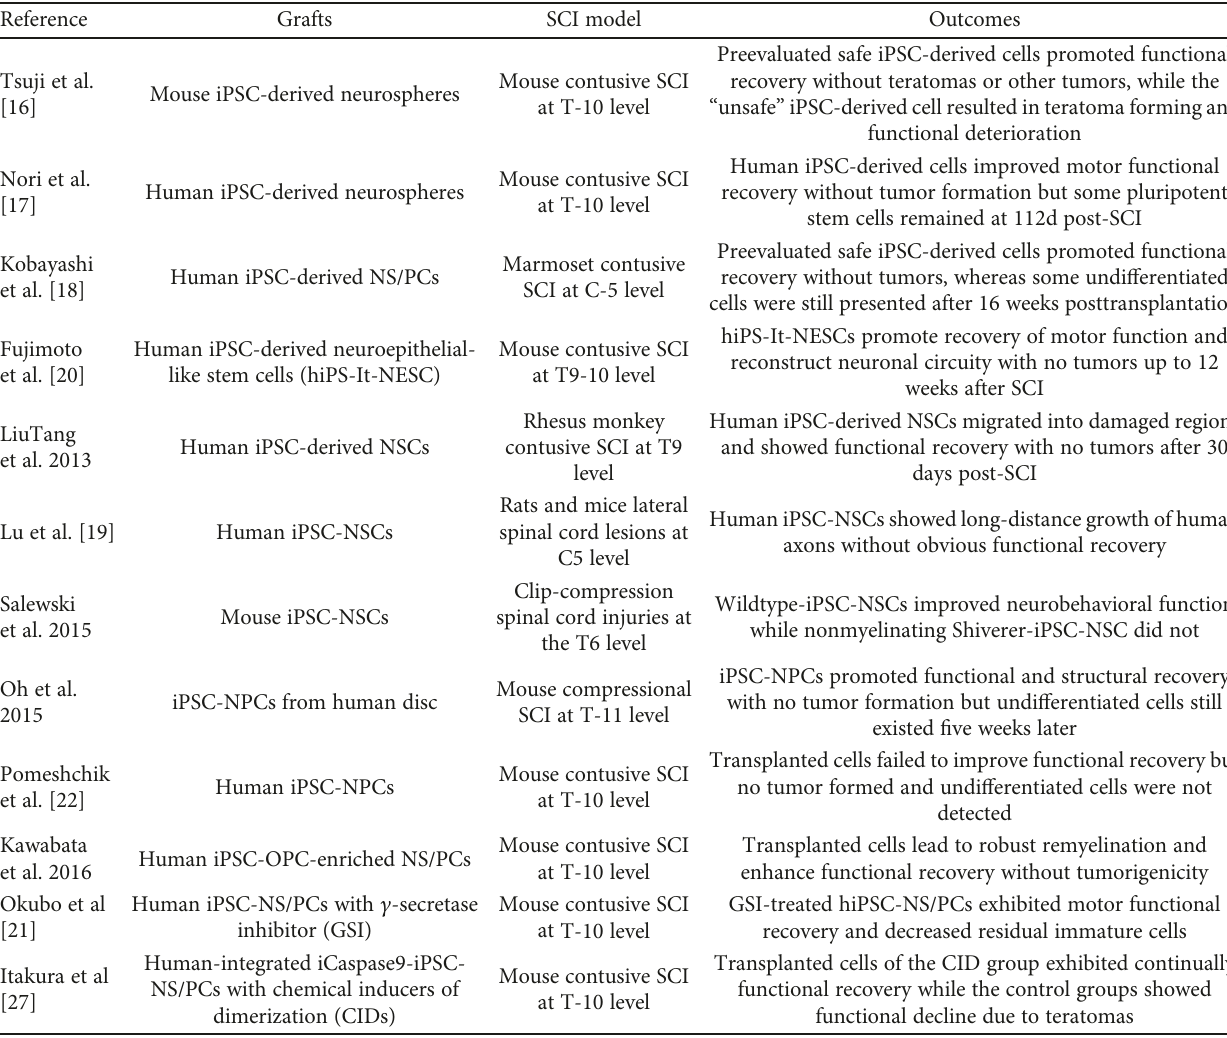
Table 1: Some current studies of iPS cell transplantation in the SCI model. This table summarizes some of the experimental studies involving iPSC derivative transplantation into SCI models and its